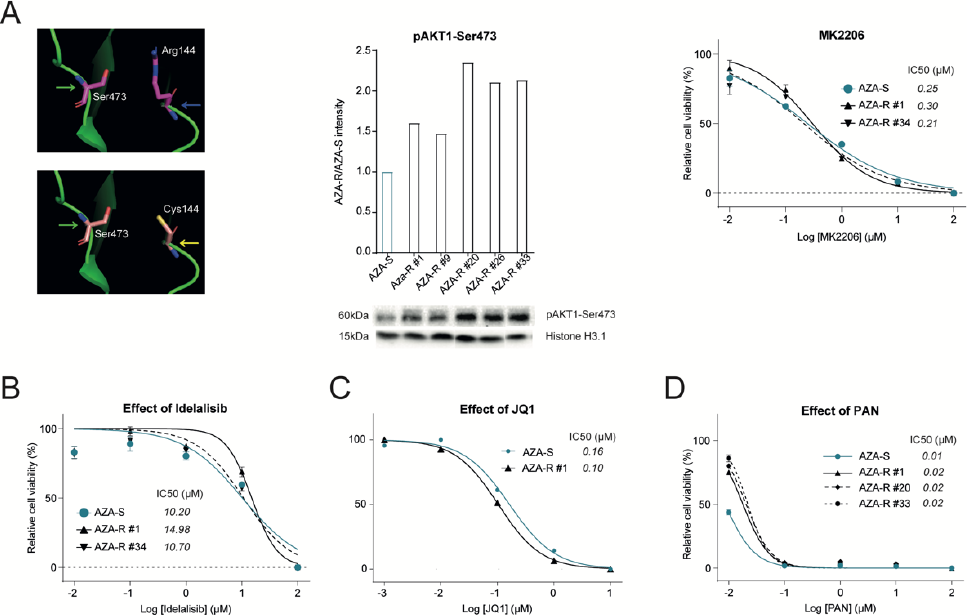
Figure 3. Validation of AZA resistance pathways. ( A left ) structural model of AKT1 variant c.430C>T (p.Arg144Cys), unmutated Arg (top, blue) vs. mutated Cys (bottom, yellow), phosphorylated Ser473 in orange; ( A middle ) AKT1-Ser473 phosphorylation (Western blotting, densitometry on top); ( A right ) WST1 assay using AKT1 inhibitor (MK2206, AZA-S vs. AZA-R). ( B ) WST1 assay; Idelalisib (IDE); ( C ) BET inhibitor JQ1; ( D ) HDAC inhibitor Panabinostat (PAN); AZA-R clones indicated by #.